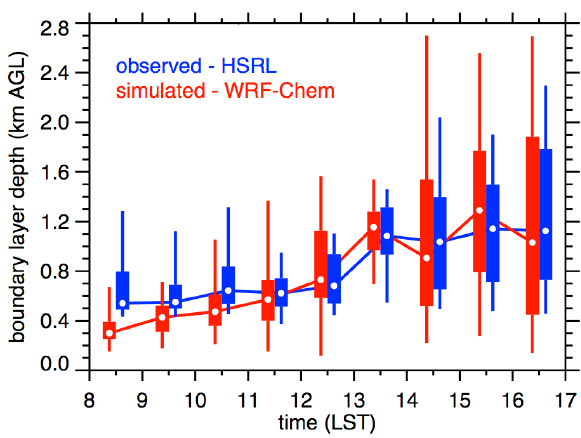
Figure 10. Observed (blue) and simulated (red) boundary layer depth along the B-200 flight paths over 996 Fig. 10. Observed (blue) and simulated (red) boundary layer depth central California in terms of percentiles for each hour of the day over the entire campaign. Filled boxes 997 along the B-200 flight paths over central California in terms of per- denote the 25 th and 75 th percentiles and vertical lines denote the 5 th and 95 th percentiles. Lines connecting 998 centiles for each hour of the day over the entire campaign. Filled the white dots denote the median value for each hour. 999 boxes denote the 25th and 75th percentiles and vertical lines denote the 5th and 95th percentiles. Lines connecting the white dots denote the median value for each